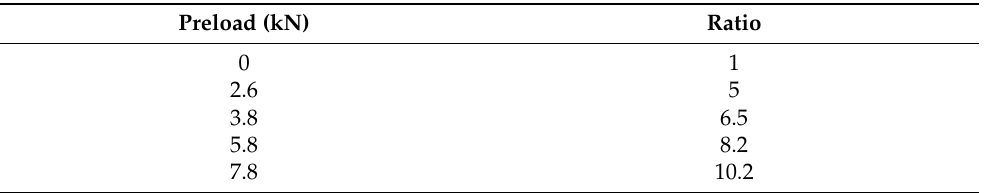
Table 10. Experimental torsional stiffness as a function of the preload. The ratio is calculated by dividing the torsional stiffness with the torsional stiffness in the case without guy-wires.